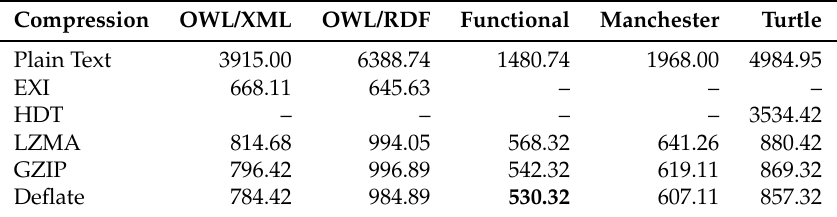
Table 3. Average size of compressed annotations.